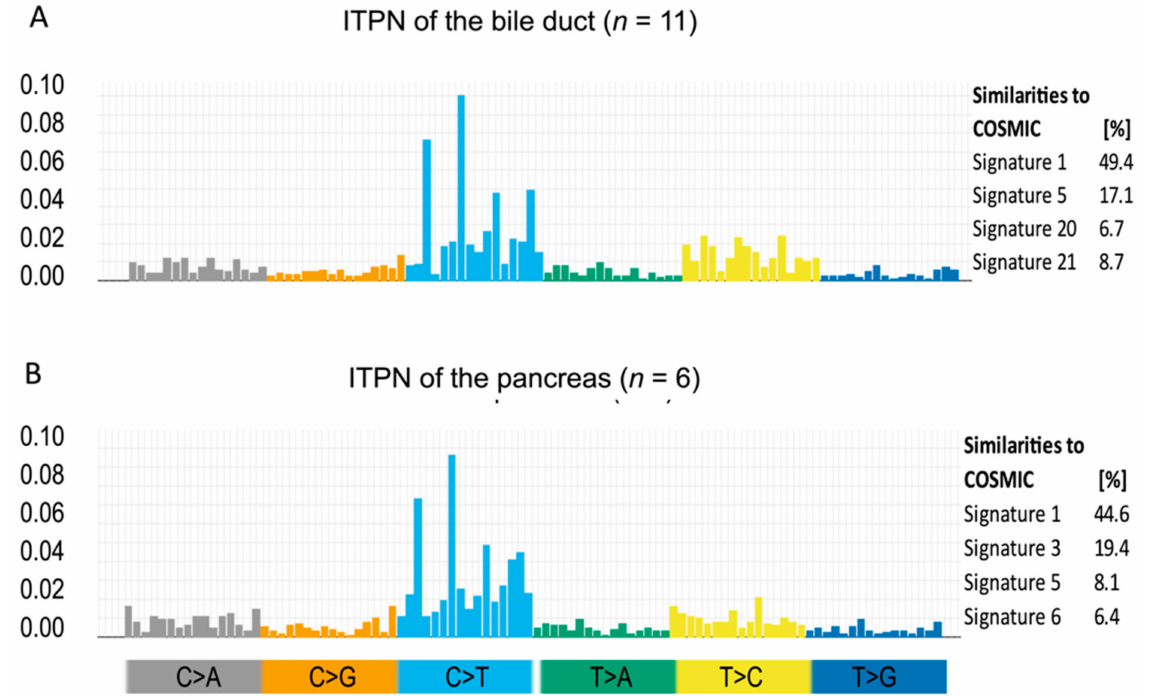
Figure 4. Mutational signature pattern analysis. Mutational signature patterns (left side) of ITPN of the bile duct ( A ) and of the pancreas ( B ), as well as their overlap with published COSMIC signatures (right side), show a resemblance to signature 1, the most common signature in all cancers, including pancreas and liver. Substitutions are displayed in the trinucleotide context and plotted on the x -axis, while fractions are shown on the y -axis. Each class of substitution is displayed by a different